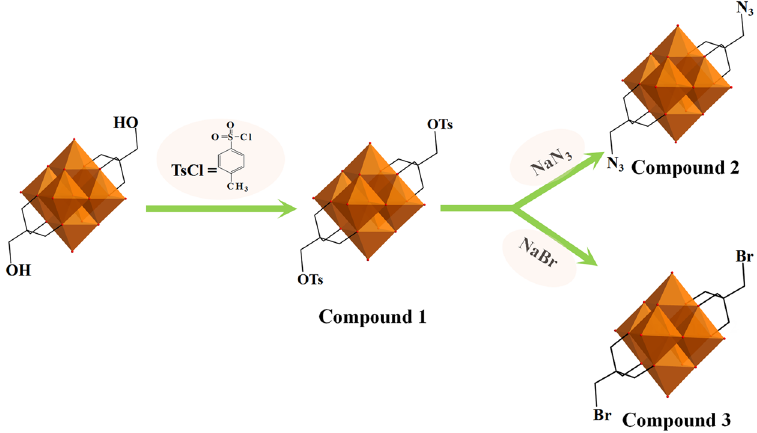
Figure 1. Step-by-step functional group transformation of